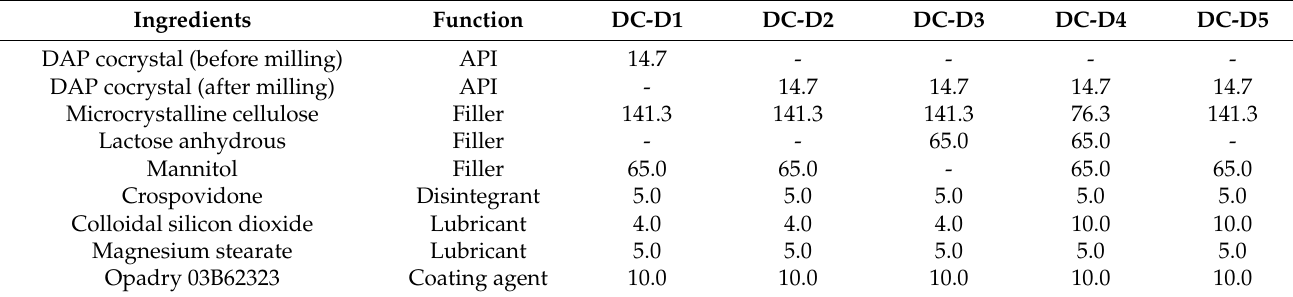
Table 1. Formulation compositions (mg) of the DAP cocrytal-loaded tablet via DC